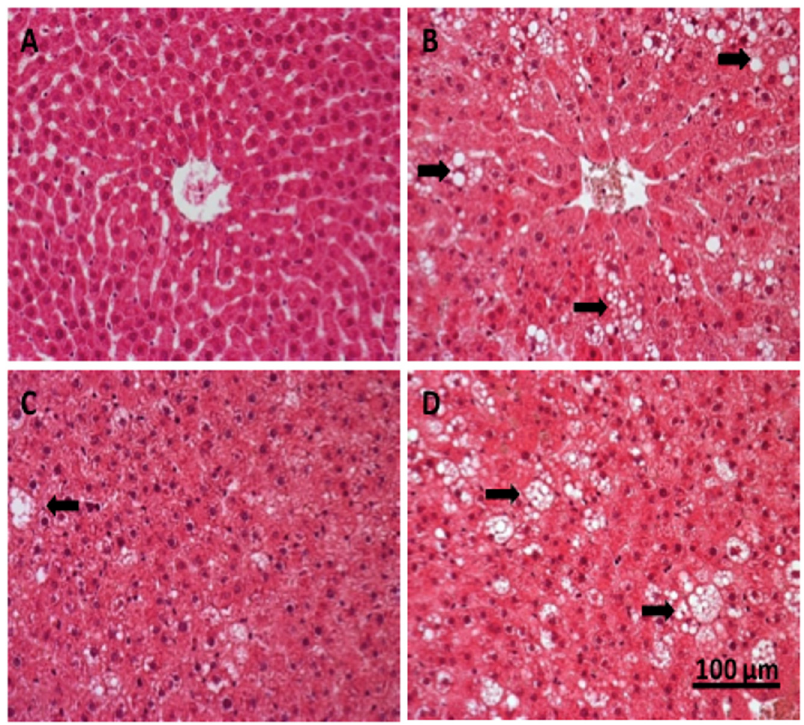
doi:10.1371/journal.pone.0151193.g004